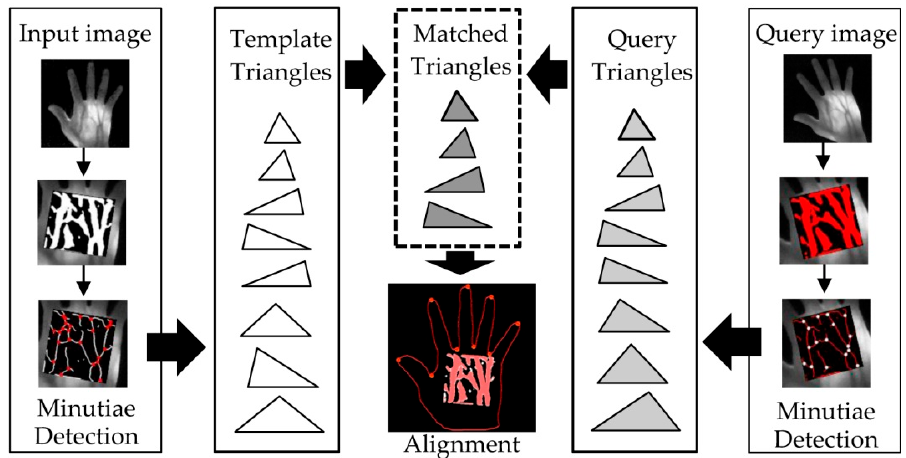
Figure 14. Registration process.